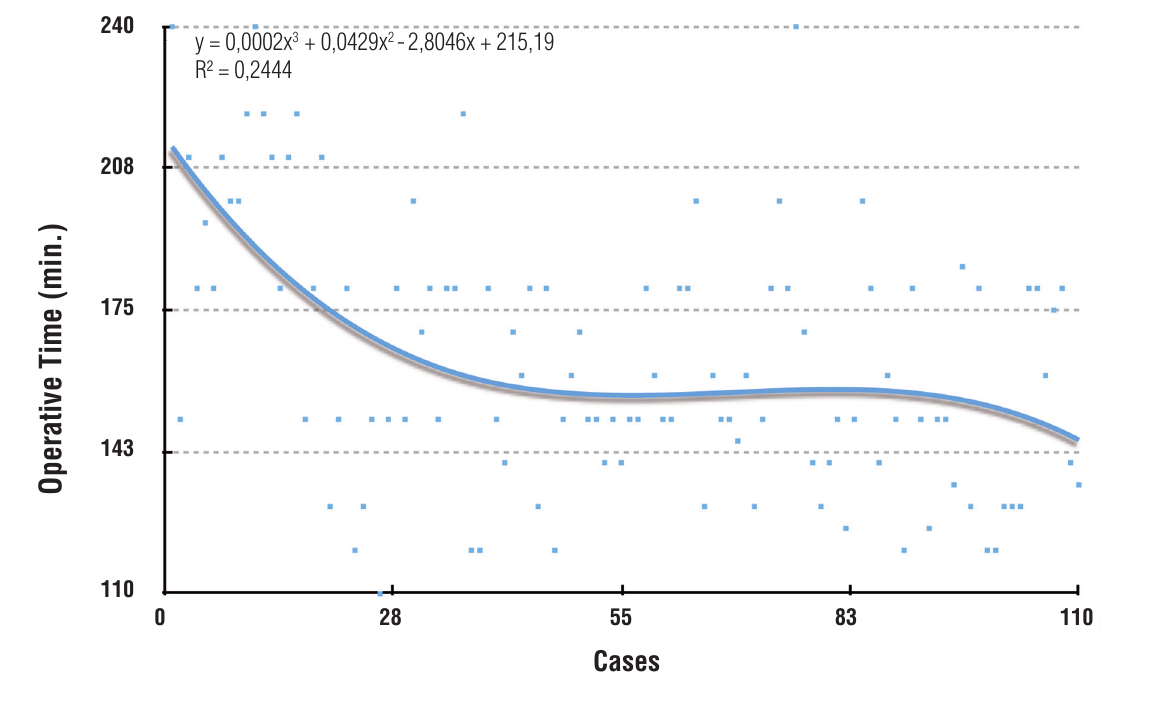
Figure 1- Learning curve for operative